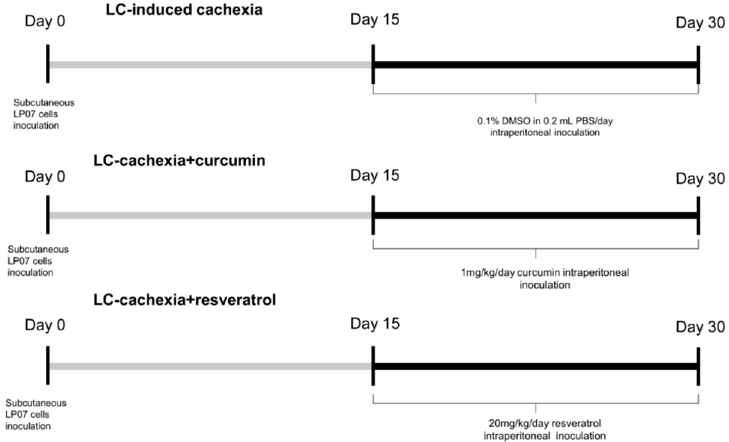
Figure 1. Schematic representation of the study protocol for all the groups of mice. Animals were kept under pathogen-free conditions with a 12:12 hour light–dark